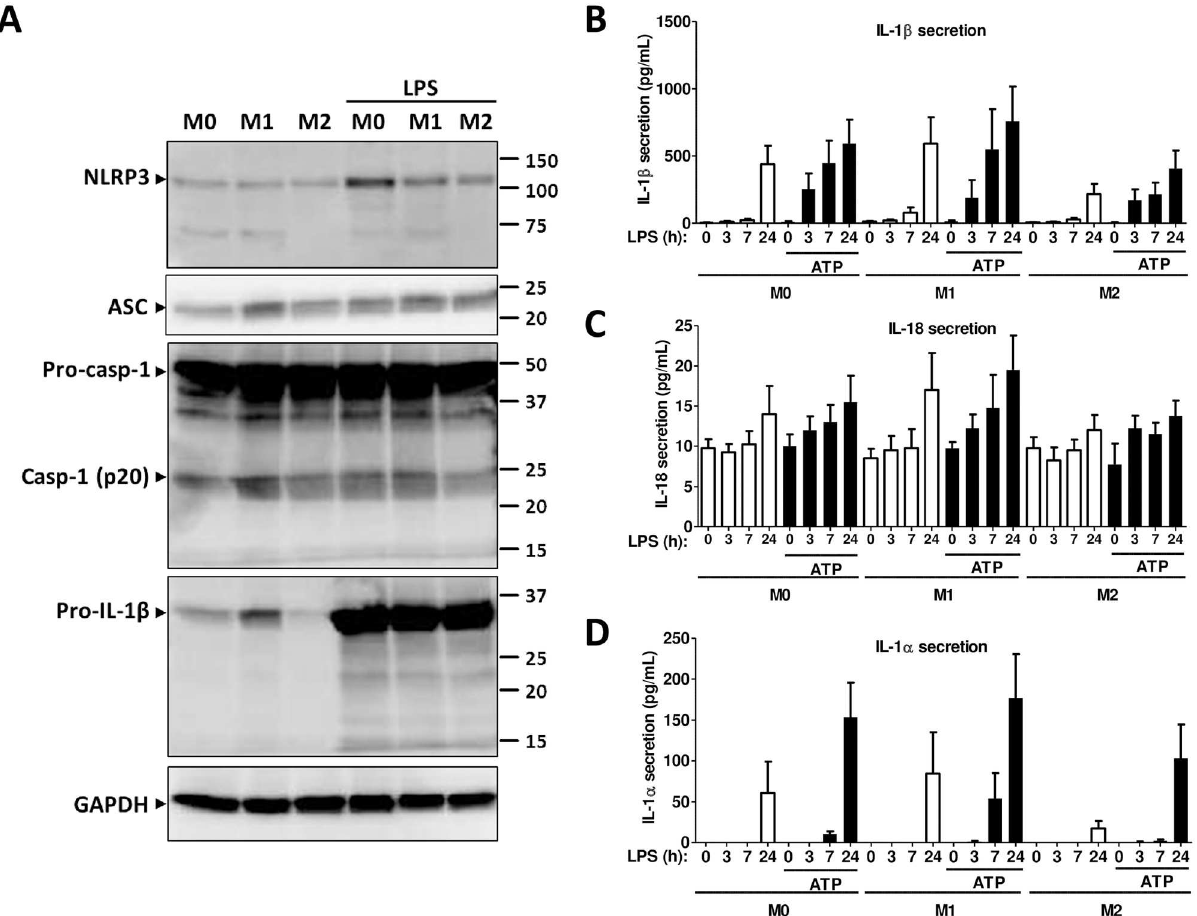
Fig 4. NLRP3 inflammasome protein expression in polarized monocytes. (A) Western blot analysisfrom total cell lysates of M0, M1 or M2 monocytes in the presenceor absenceof LPS using an anti-NLRP3, an anti-ASC, an anti-caspase-1 or an anti-IL-1 β antibody.GAPDH was used as loading control. Blots are representative of (cid:21) 3 independentexperiments. (B-D) IL-1 β , IL-1 α and IL-18 secretionas assessed by ELISA in cell culture supernatantsof M0, M1, or M2 monocytes after activationof NLRP3 inflammasome with 100 ng/ml LPS for the indicatedtime in the presenceor absenceof 5mM ATP for the last 30 minutes. M0: cells treated with completemedium (control); M1: cells treated with 100 ng/ml IFN- γ (polarizedtowards M1); M2: cells treated with 10 ng/ml IL-4+IL-13 (polarizedtowards M2). Data represent the mean ± SEM of (cid:21) 4 independentexperiments donein monocytes isolatedfrom buffy coats of (cid:21) 4 independentdonors.